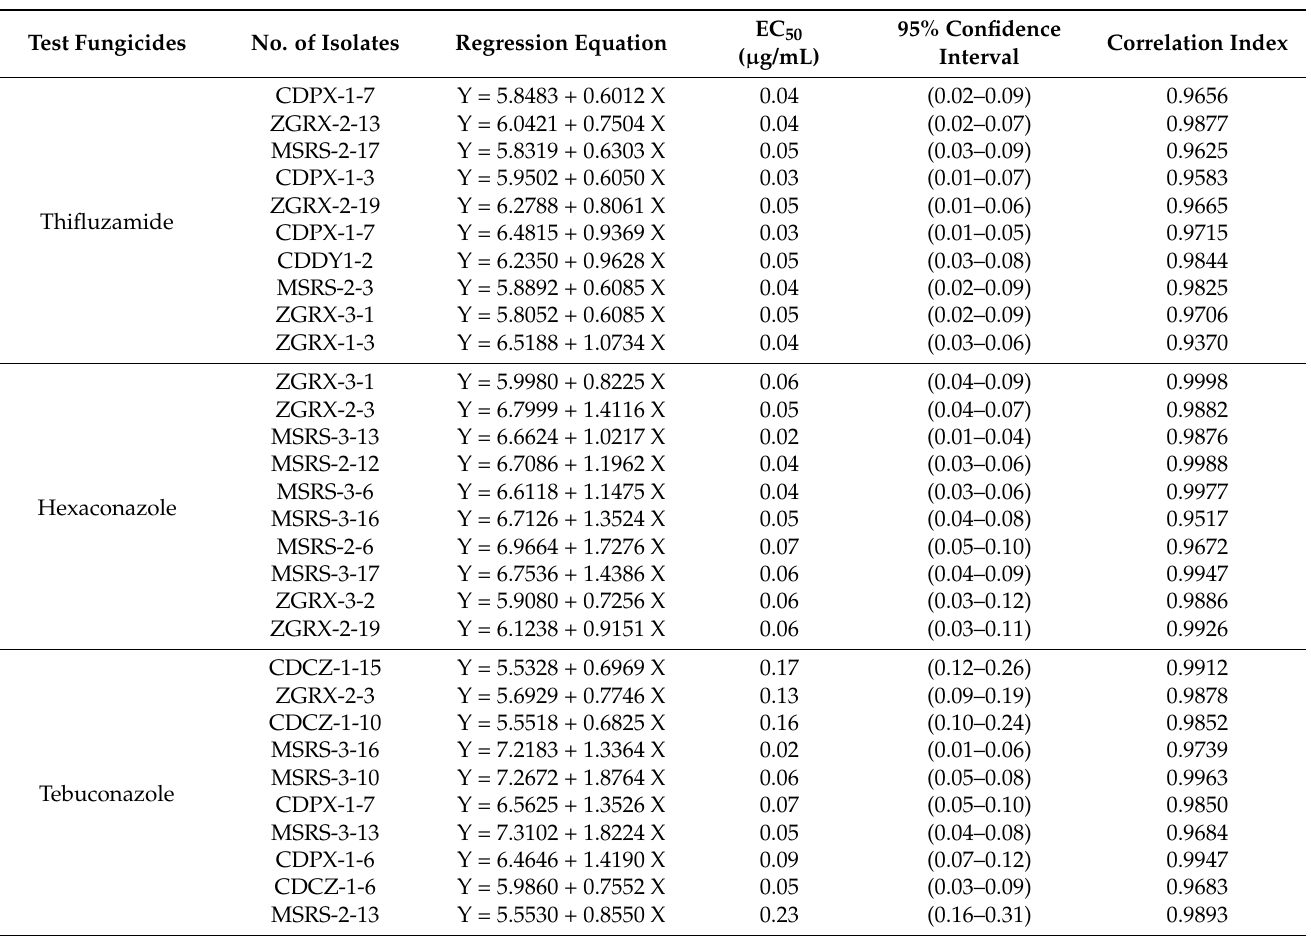
Table 2. Determination of sensitivity baseline of R. solani isolates to four tested